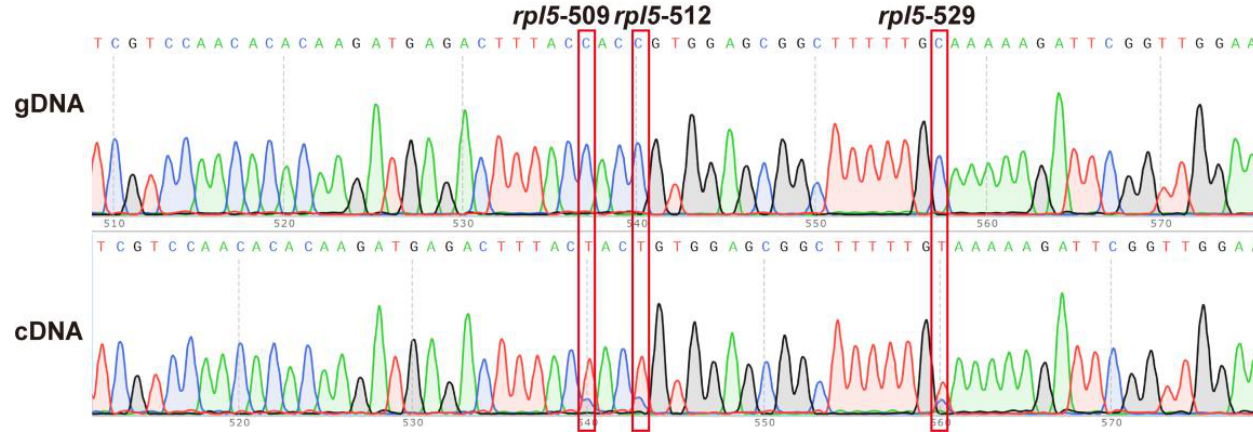
Figure 9. Validation of three predicted RNA editing sites ( rpl5 -509, rpl5 -512, and rpl5 -529) using PCR and Sanger sequencing. The top panel shows the sequences and chromatographs from the PCR products amplified using gDNA as the template. The bottom panel shows the sequences and chromatographs from the PCR products amplified using the cDNA. The gene names and the RNA editing sites’ positions are shown at the top of the figure, separated with “-”. The red squares highlight the focal RNA editing site. rpl5 -529 created a new stop codon upstream from the stop codon found in the genomic sequence.